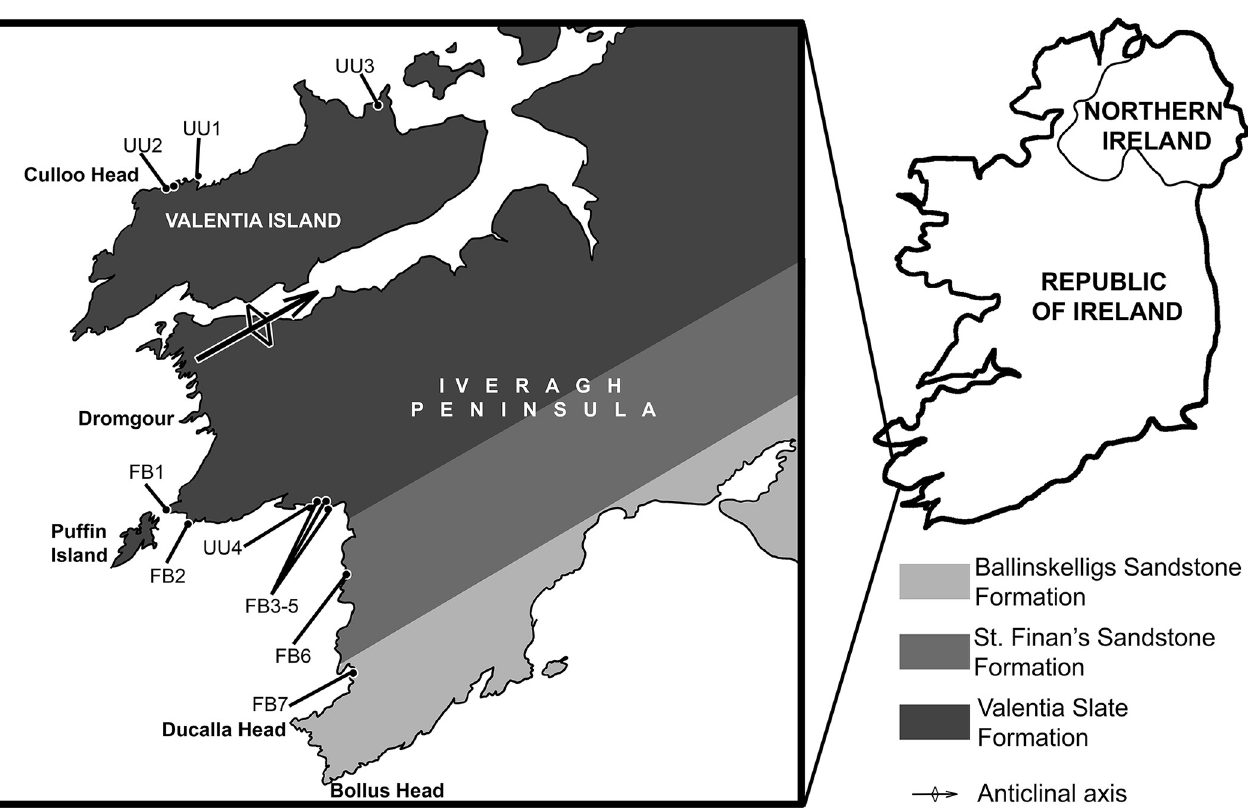
Fig 1. Geographic context and main geological ensembles of the Iveragh Peninsula, with location of Bothriolepis localities.